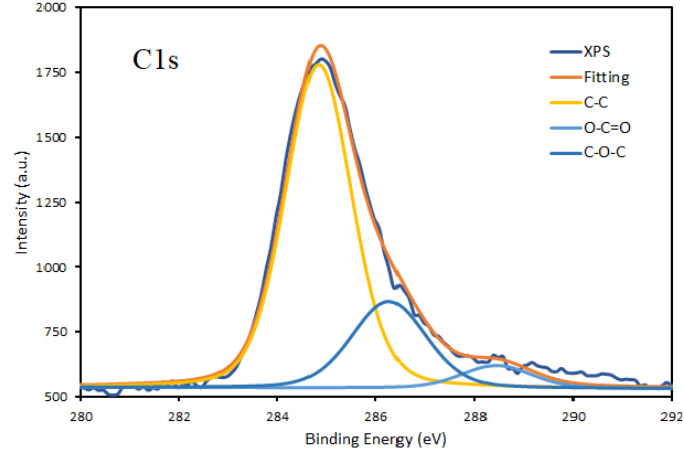
Figure 7. Fitting of C1s peak of the thin film deposited onto titanium substrates by DC plasma jet in condition A.